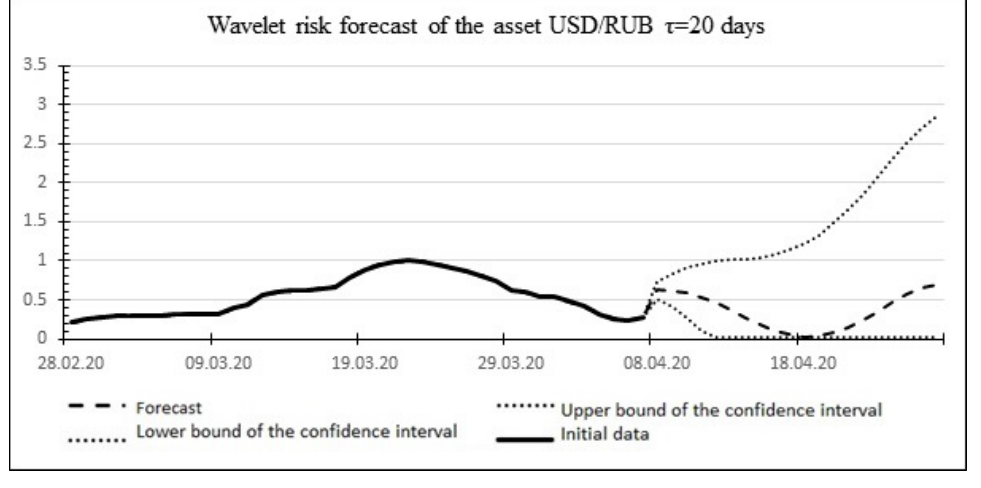
Figure 10. Wavelet asset risk